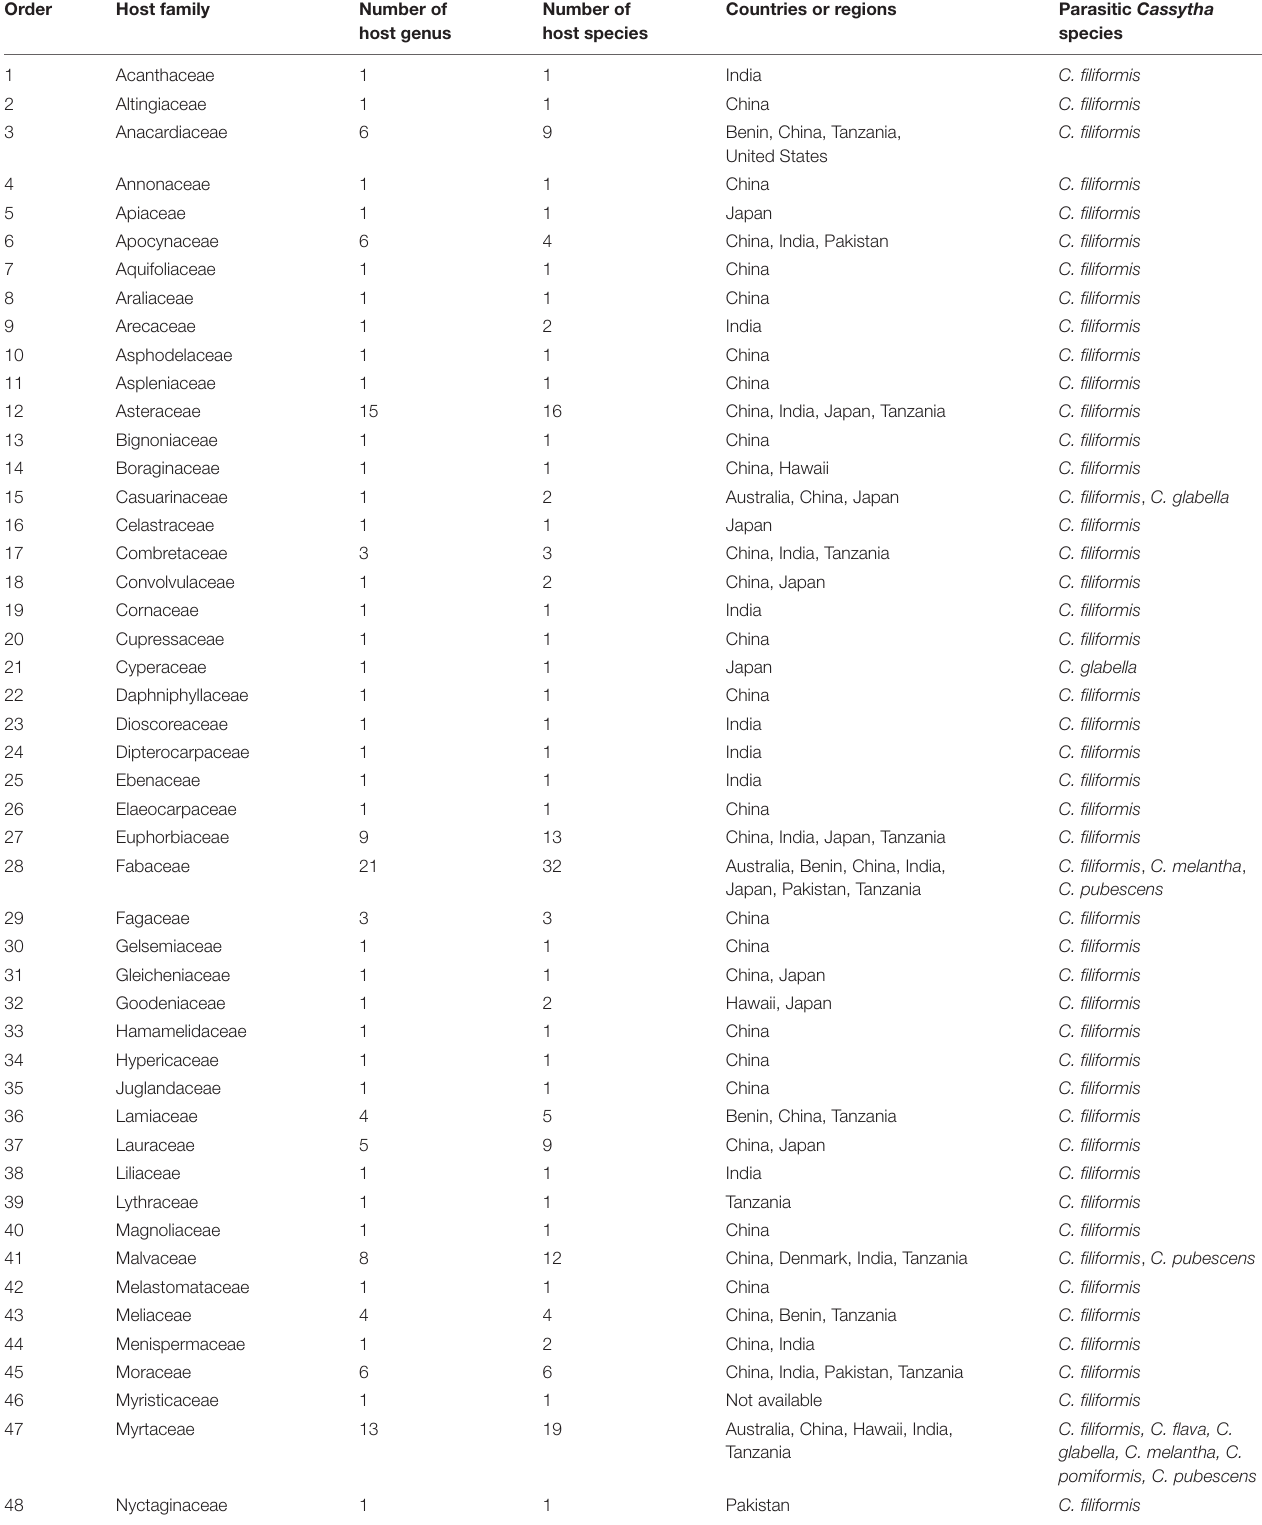
TABLE 2 | Host plant family susceptible to Cassytha infestation all over the world.